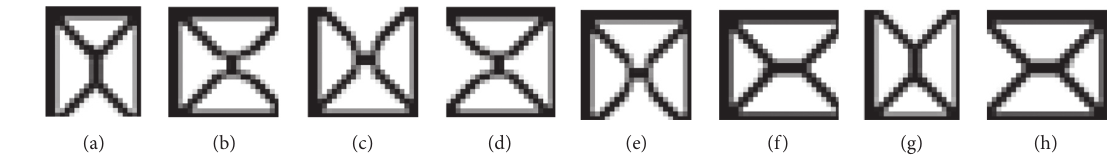
Figure 2: Eight pattern elements. (a–h) Elements with labels 0–7.